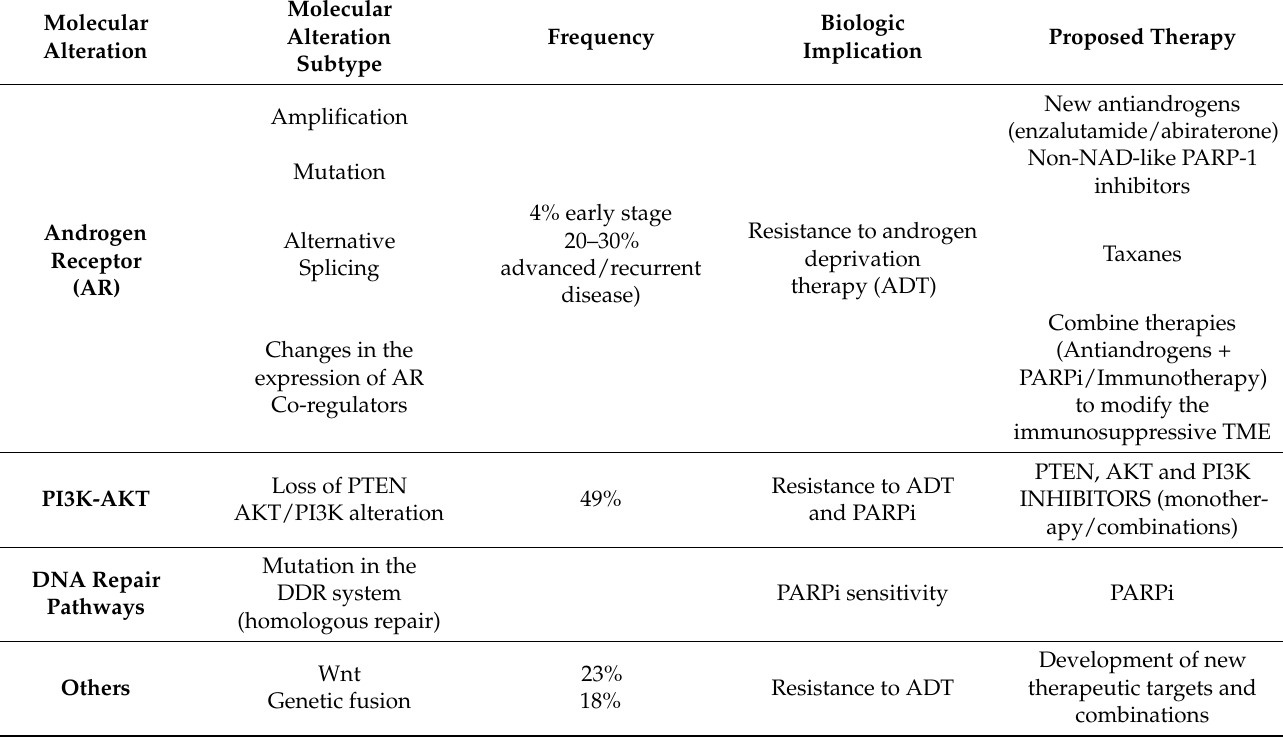
Table 1. Molecular subtypes for prostate cancer